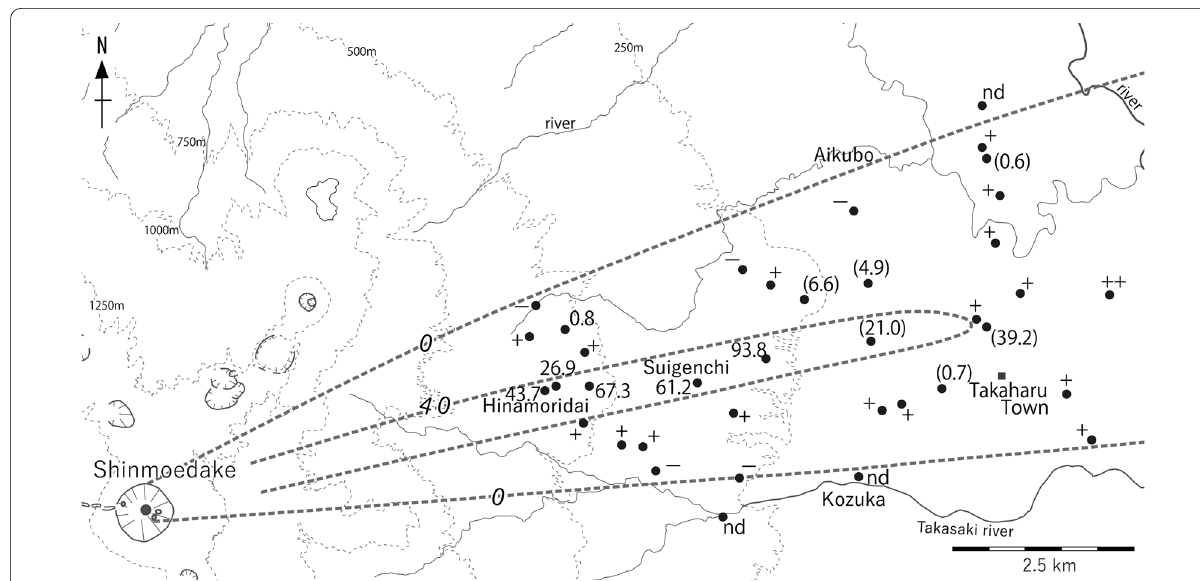
Fig. 2 Ashfall distribution map of the June 27, 2018 eruption. Numerical values are the amounts of ashfall (g/m 2 ). Values with parentheses have lower accuracy. Marks of the points as volcanic ash abundant ( 40-g/m 2 isolines obtained via the field